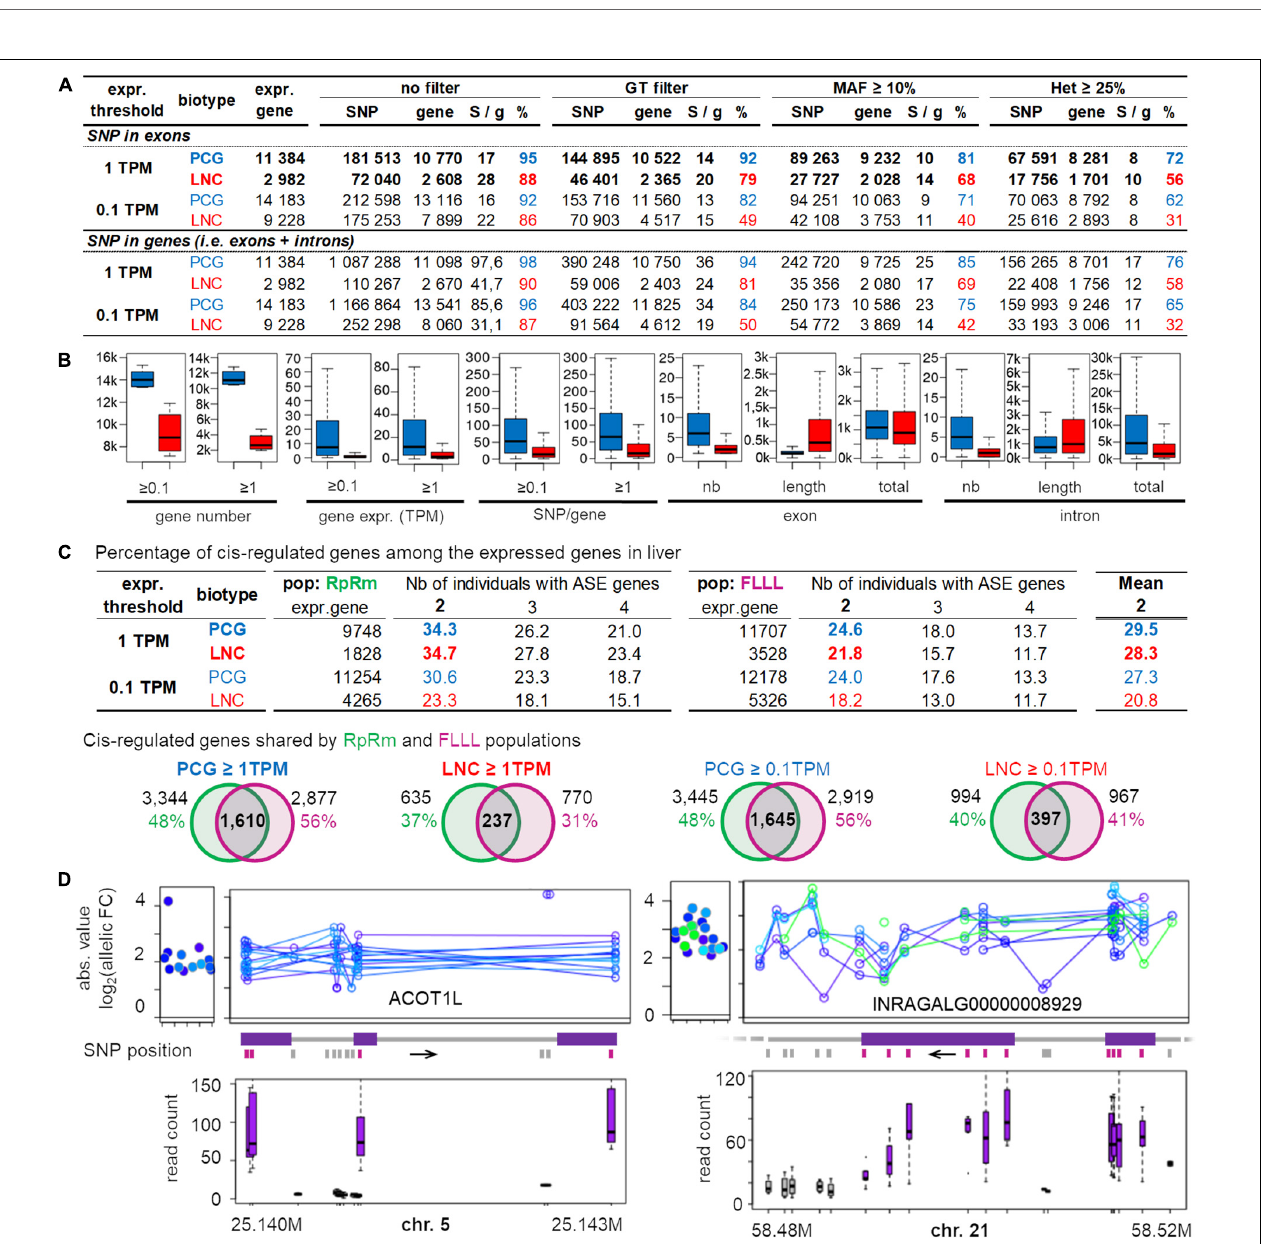
FIGURE 7 | Overview of the analyzable genes for allele-specific expression in the liver of various populations for two gene biotypes, Protein Coding Gene (PCG) and Long Non-Coding gene (lncRNA), at two gene expression thresholds (0.1 TPM and 1 TPM) and for 3 filters. (A) Average numbers for all populations analyzed here. These average numbers are provided for both PCG (blue) and lncRNA (red) biotype, with minimum expression of 0.1 or 1 TPM (“expr. threshold”), and considering only the SNPs in exons (top part) or in the whole gene, i.e., in both exons and introns (bottom part). (B) Feature of lncRNA and PCG. (C) Percentage of gene with a significant allele specific expression in two populations RpRm (in left) and FLLL (in right) in comparison to the expressed gene number. Venn diagrams provide the number of ASE genes (in at least 2 individuals) shared by RpRm and FLLL populations. (D) Overview of the ASE of ACOT1L (left) and INRAGALG00000008929 (right). For each ASE sample, absolute values of the log2 allelic fold-change are represented at the gene-level (left of the panels) and for each SNP located in the haplotype used by phASER (right). Boxplot of the read number associated to each SNP are represented (bottom), in purple for the SNP located in exons and in gray for those in introns. FC, fold-change; chr,